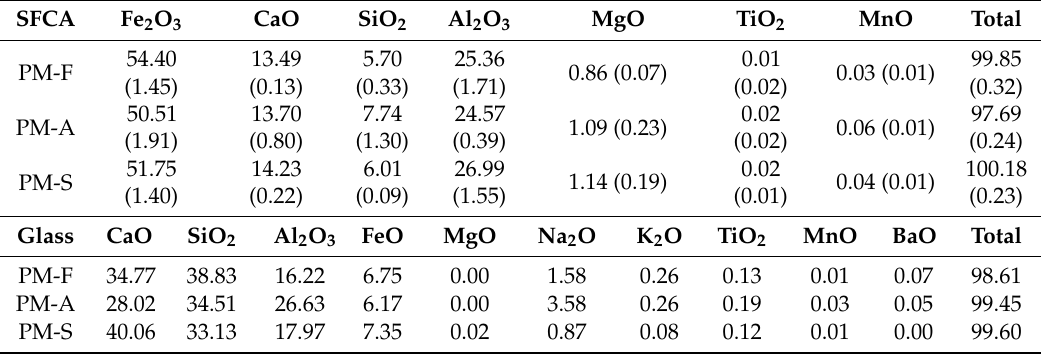
Table 4. Electron Probe Microanalysis (EPMA) of the SFCA crystals and glass phase within samples with standard deviations for ~10 point analyses in the parentheses,